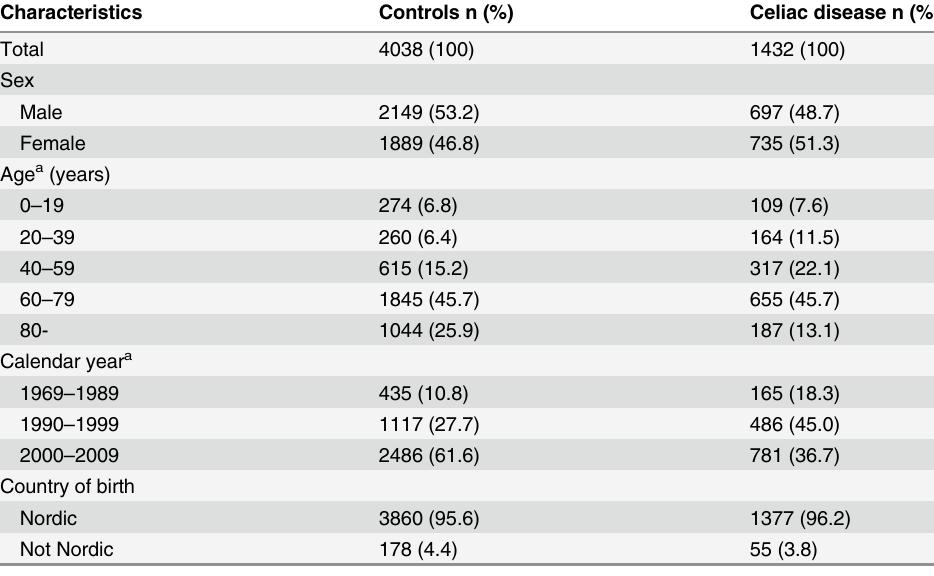
Table 1. Characteristics of individuals with